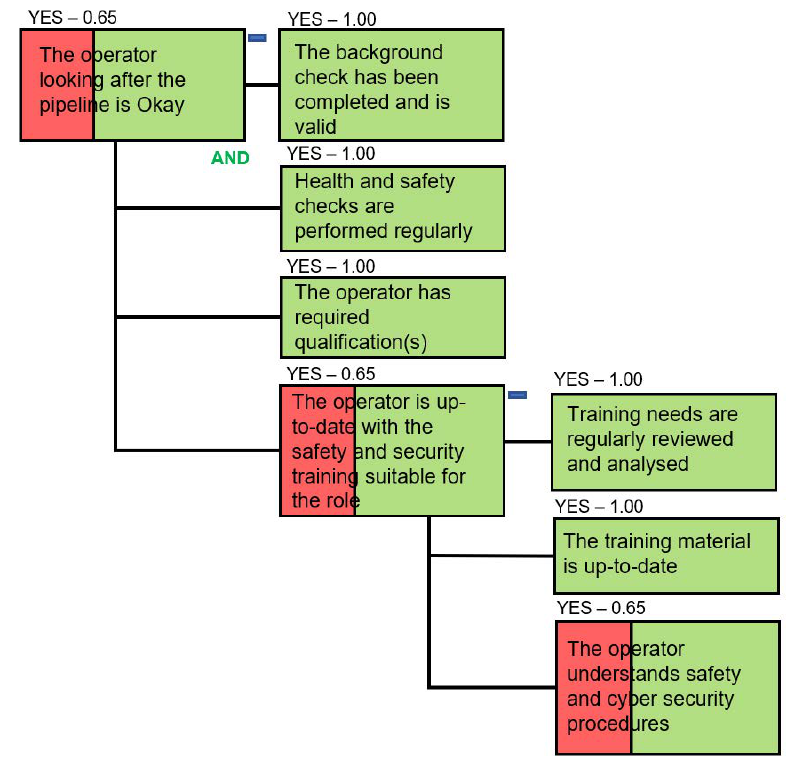
Figure 7. Dependencies of the Paragon Employees